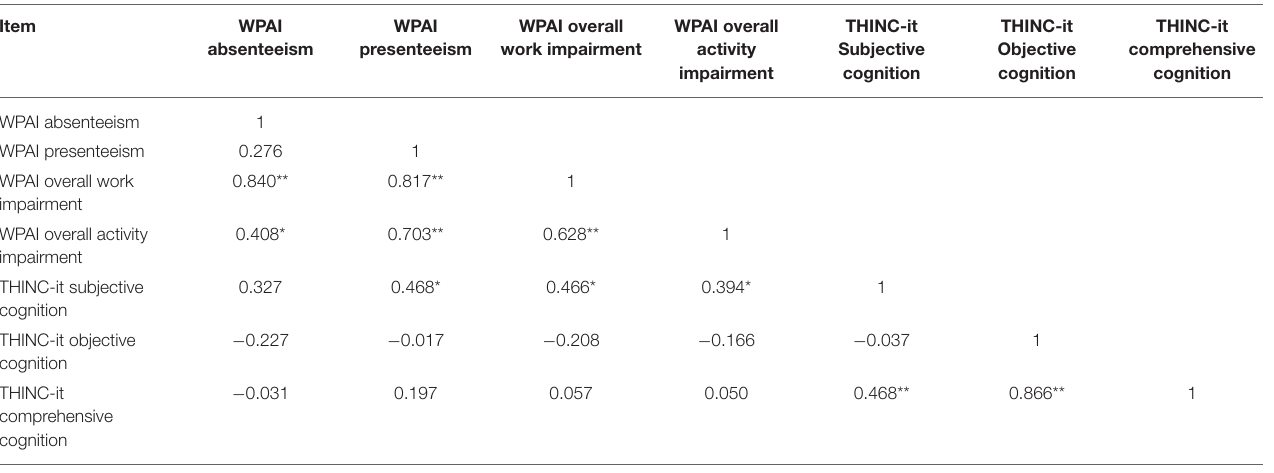
TABLE 5 | Correlation analysis between THINC-it and WPAI.